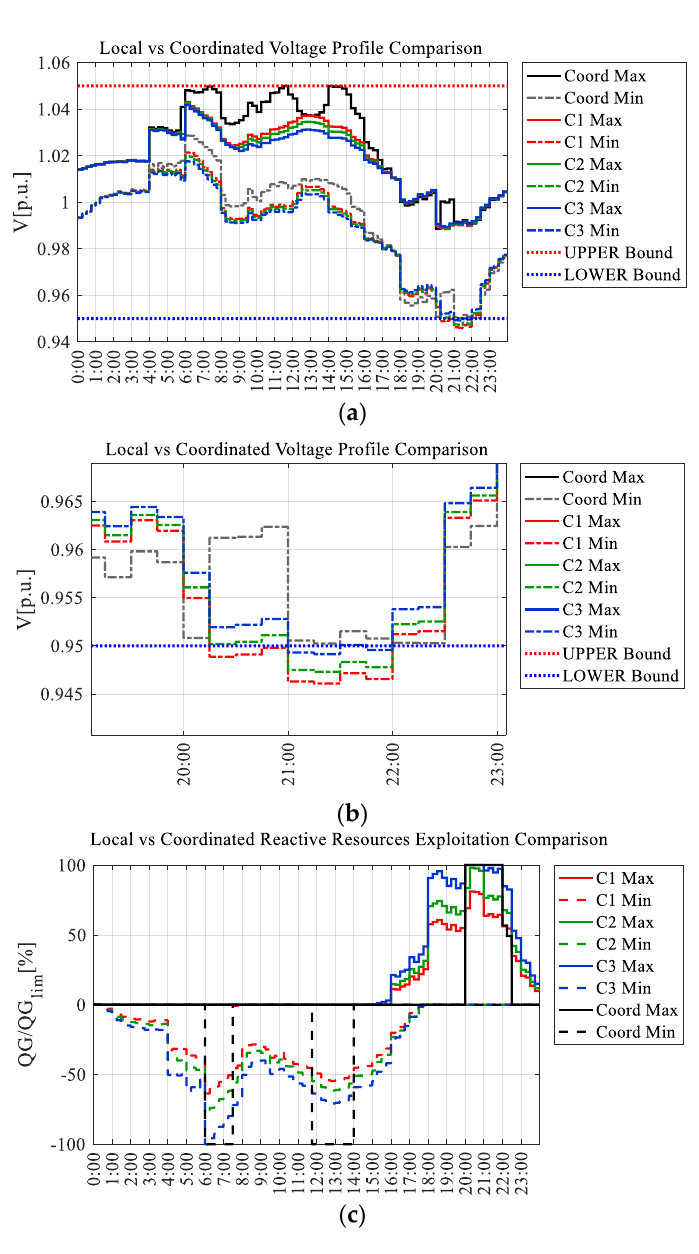
Figure 14. Local vs Coordinated Control results: ( a ) DN’s voltage profile; ( b ) DN’s voltage profile—detail of night hours; ( c ) DGs reactive power response with respect to available capability.